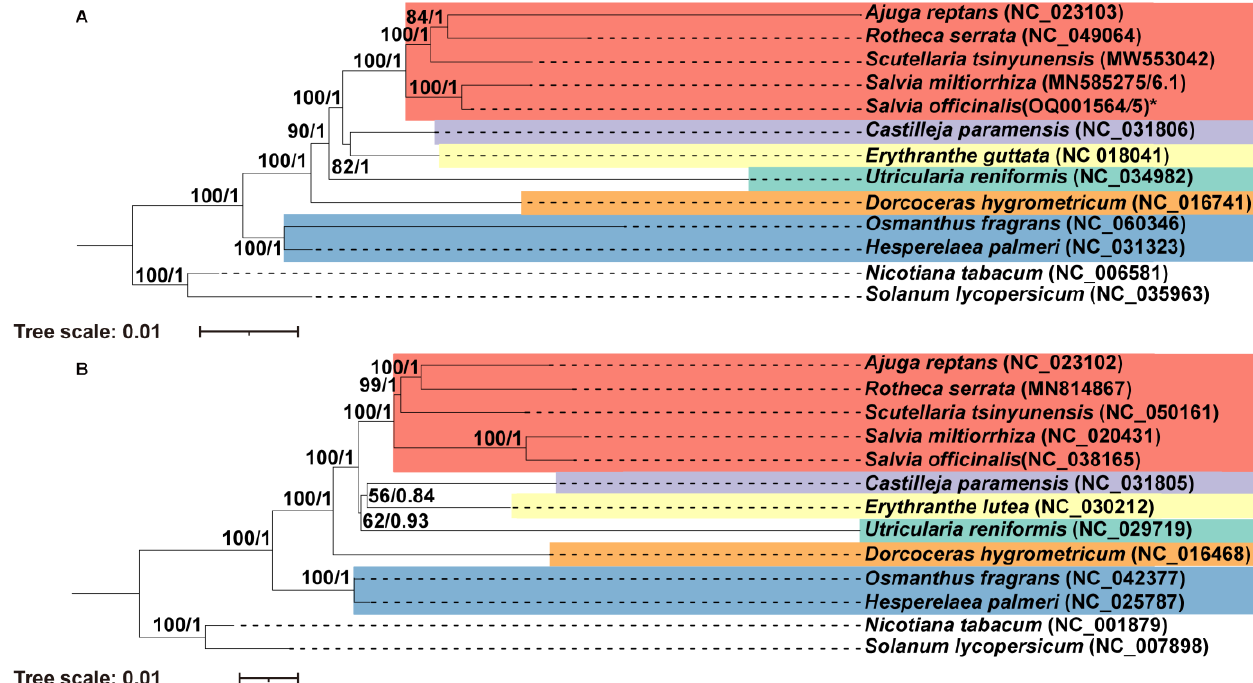
Figure 8. Molecular phylogenetic analysis of Salvia officinalis and its 10 close Lamiales relatives and two non-Lamiales species based on mitogenomes ( A ) and plastomes ( B ). The tree was constructed using concatenated conserved protein sequences from the mitogenomes of 11 Lamiales and 2 non-Lamiales species via the ML and BI methods. The bootstrap score was obtained by employing 1000 replicates. The ML bootstrap support values and BI posterior probabilities were labeled at the corresponding nodes. Two species from Solanaceae ( Nicotiana tabacum and Solanum lycopersicum ) were used as outgroups. The mitogenome assembled in this study was labeled with an asterisk.